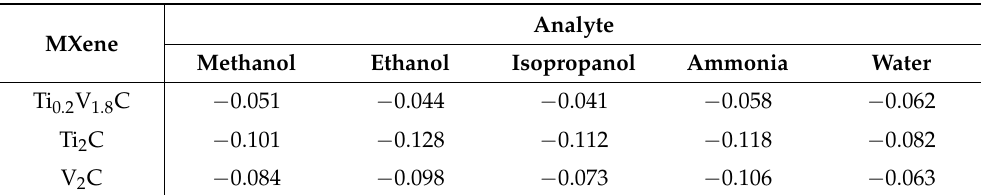
Table 2. The calculated binding energy, eV, characterizing the interaction of analyte molecules with MXene surfaces. Analyte MXene Methanol Ethanol Isopropanol Ammonia Water